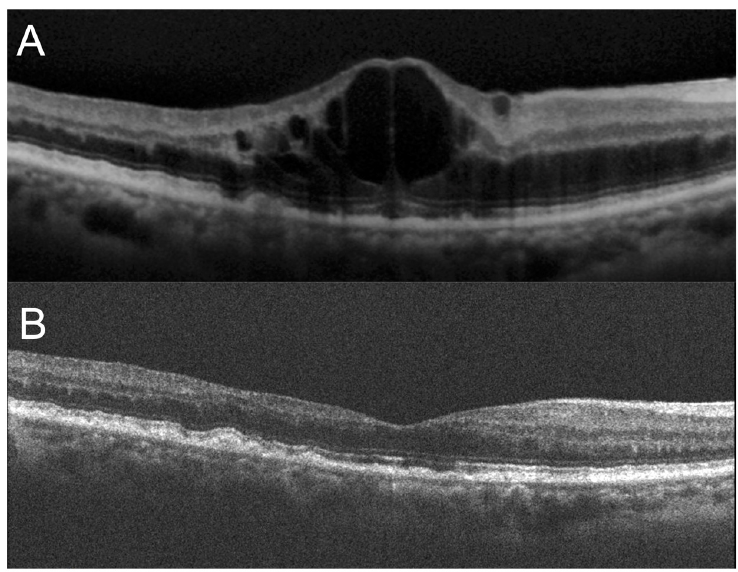
Figure 1. Optical coherence tomography images of an 84-year-old woman with cystoid macular edema secondary to central retinal vein occlusion (CRVO-CME). ( A ) At baseline, CRVO-CME was